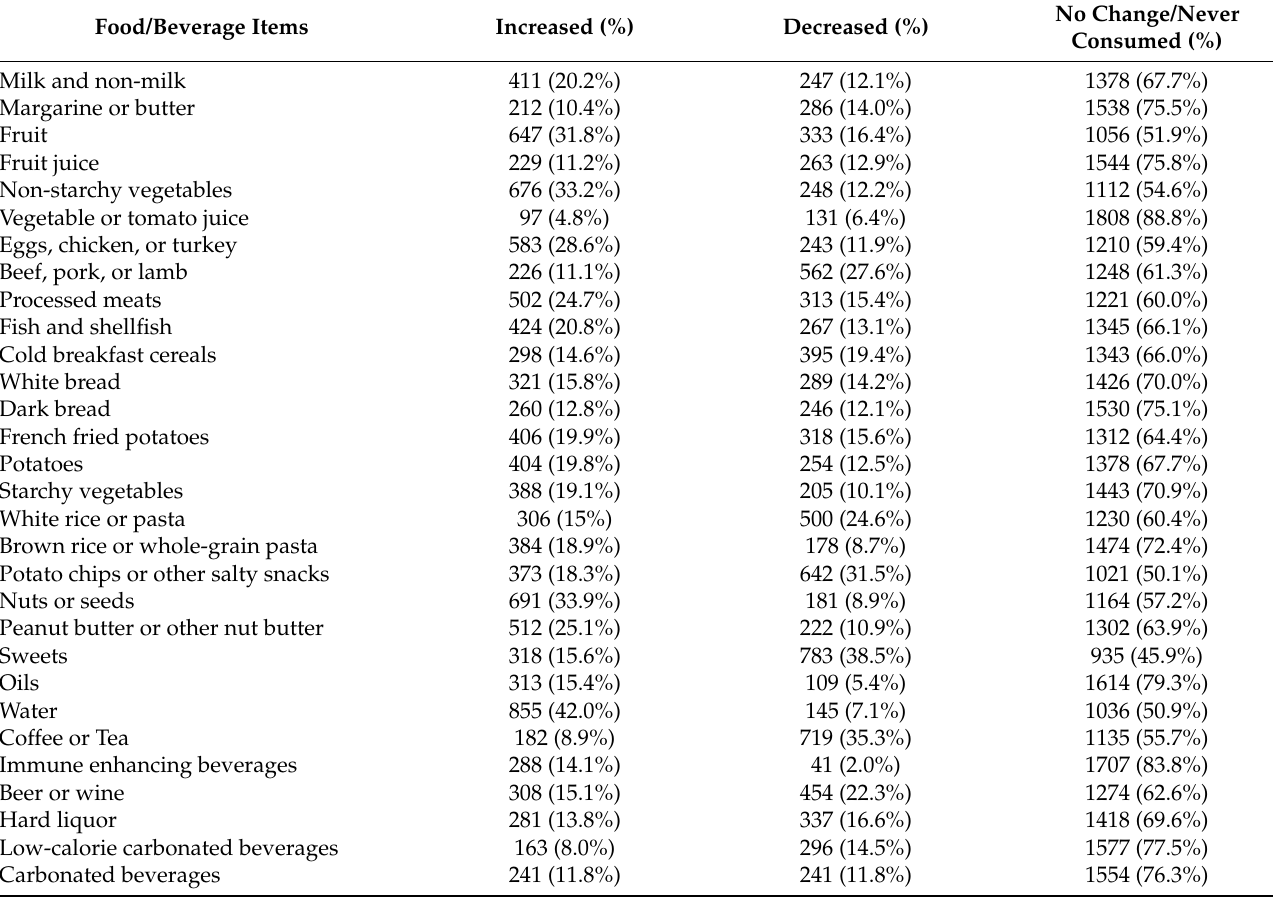
Table 4. Frequency and counts of foods/beverages consumed since March 2020 ( n =